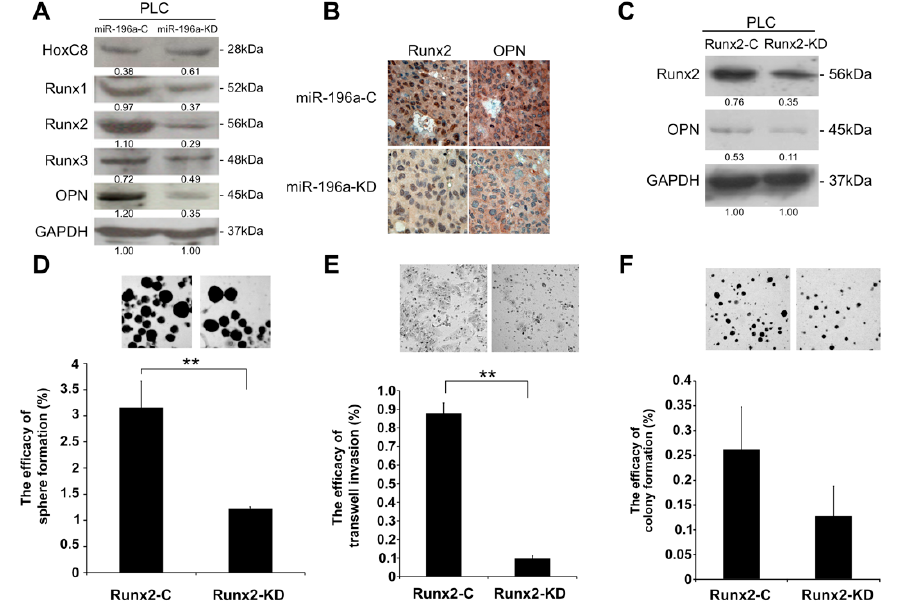
Figure 5. Runx2 knockdown reduced self-renewal and transwell invasion of PLC cells. ( A ) Western blot revealed that miR-196a downregulation decreased Runx family and osteopontin (OPN) expression of PLC cells. ( B ) Immunohistochemistry showed that the expression of Runx2 and OPN were decreased in xenografts derived from miR-196a-KD (original magnification, ×400). ( C ) Western blot revealed the levels of Runx2 and OPN in Runx2 knockdown (Runx2-KD) and control (Runx2-C) PLC cells. ( D–F ) Knockdown of Runx2 significantly decreased the sphere formation of PLC cells ( D ) and transwell invasion ( E ), but not colony formation ( F ) (original magnification, ×50 ( D ), ×100 ( E ), ×25 ( F ), ** p < 0.01).